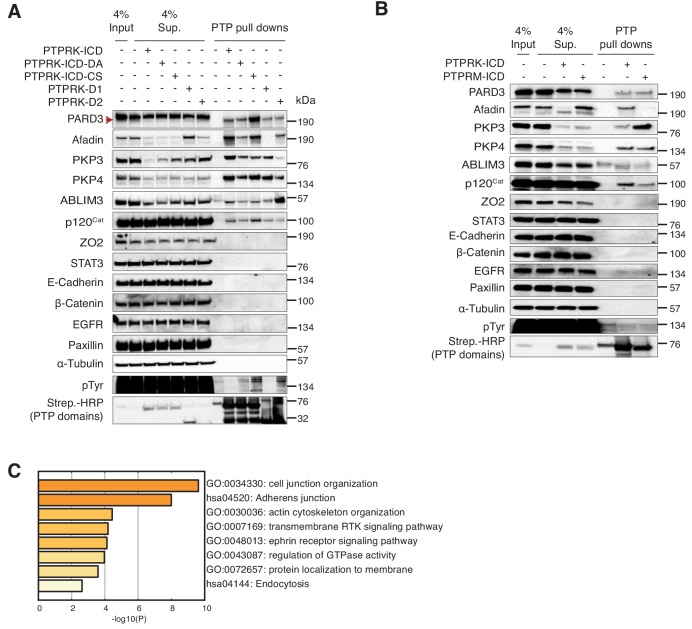
The PTPRK-dependent tyrosine phosphoproteome is enriched for cell junction organization proteins.(A–B) PTPRK interactors identified by mass spectrometry were validated using pull downs with the specified PTPRK and PTPRM protein domains from pervanadate-treated, confluent MCF10A cell lysates followed by immunoblot analysis. Input and supernatants reveal the extent of protein depletion by recombinant proteins. (C) GO term analysis using Metascape of proteins with increased tyrosine phosphorylation in PTPRK KO MCF10As. FDR = 0.01, one valid value required.